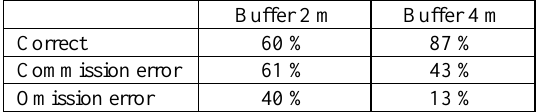
Table 1. Accuracy assessment of the forest and shrub-land border. Table 2. Comparison of automatic and reference segmentation.